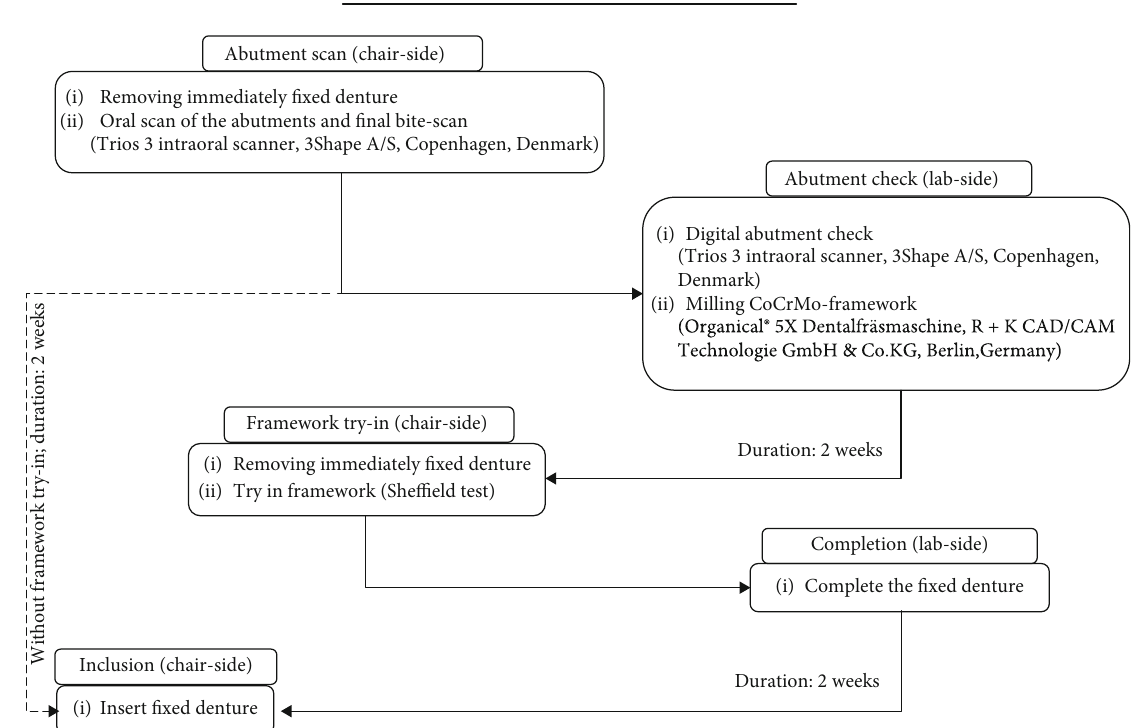
Figure 9: Overview of the 2 nd treatment phase.